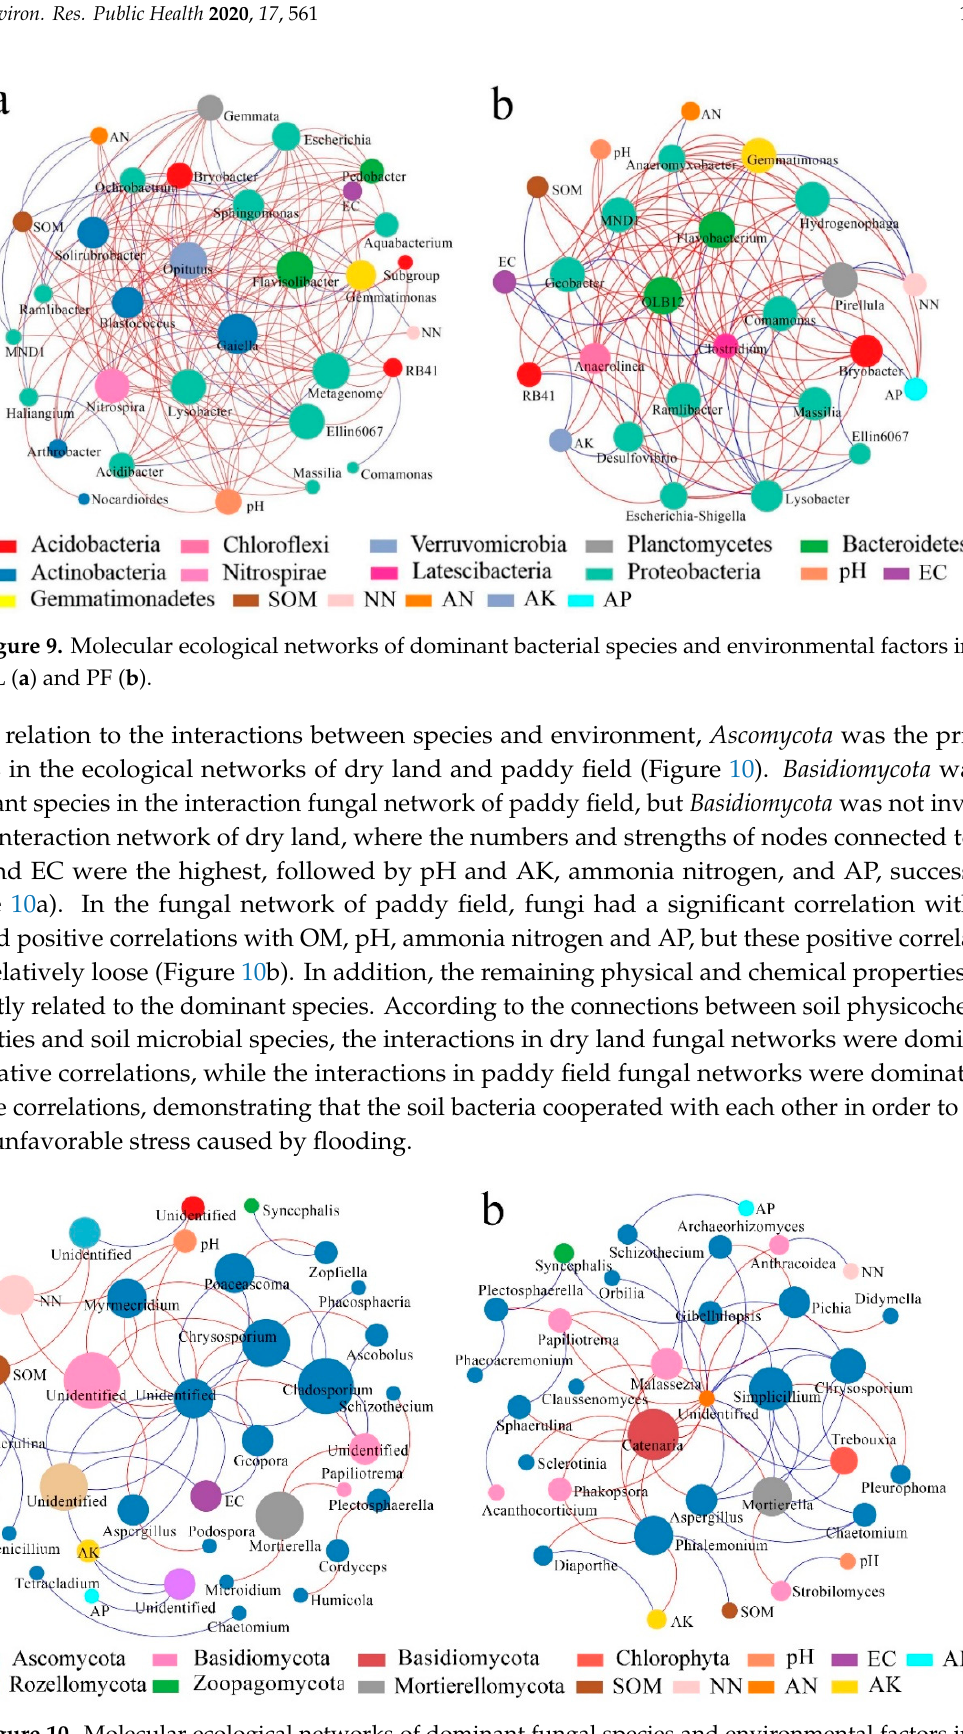
Figure 10. Molecular ecological networks of dominant fungal species and environmental factors in DL ( a ) and PF ( b ).